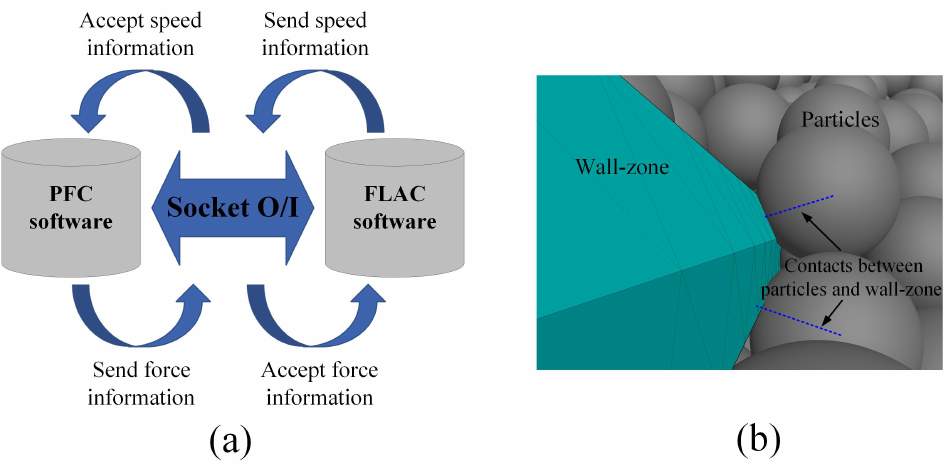
Figure 4. Coupled PFC–FLAC simulation principles schematic diagram. ( a ): coupling principles ( b ): particles and wall-zone contacts